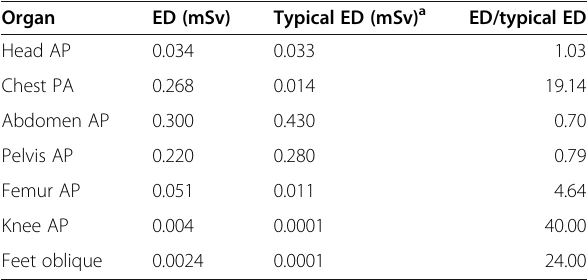
Table 1 Rough estimation of effective dose in the study and literature values for different